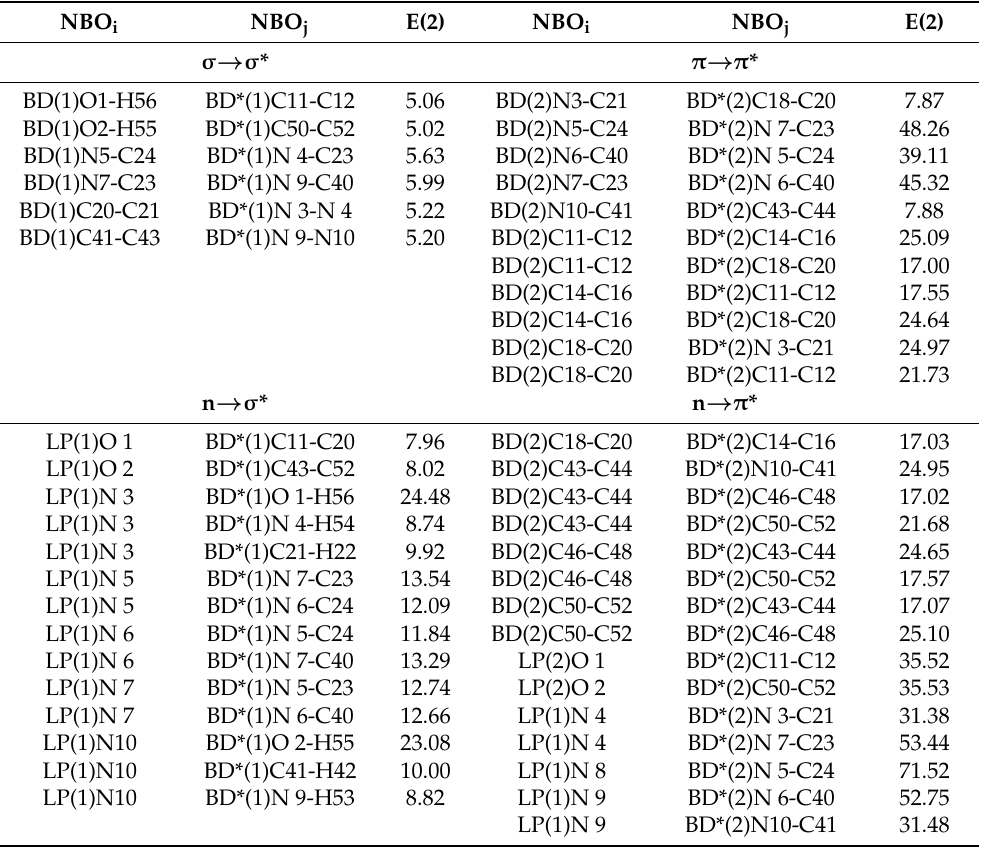
Table 6. The IMCT processes and E (2) values calculated using NBO method.